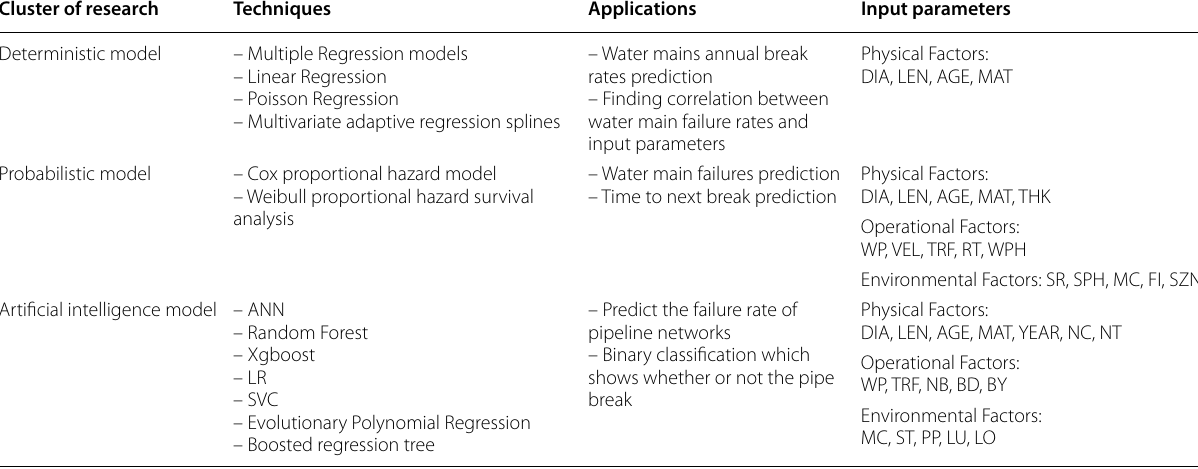
Table 1 A summary of predictive analytics applications for water pipes failure Cluster of